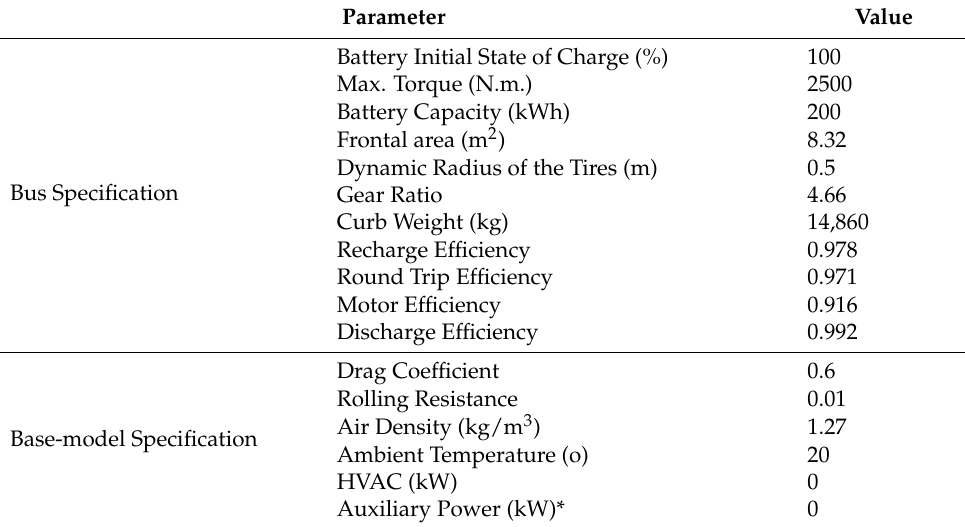
Table 3. Base model parameters for BEB energy consumption simulation.